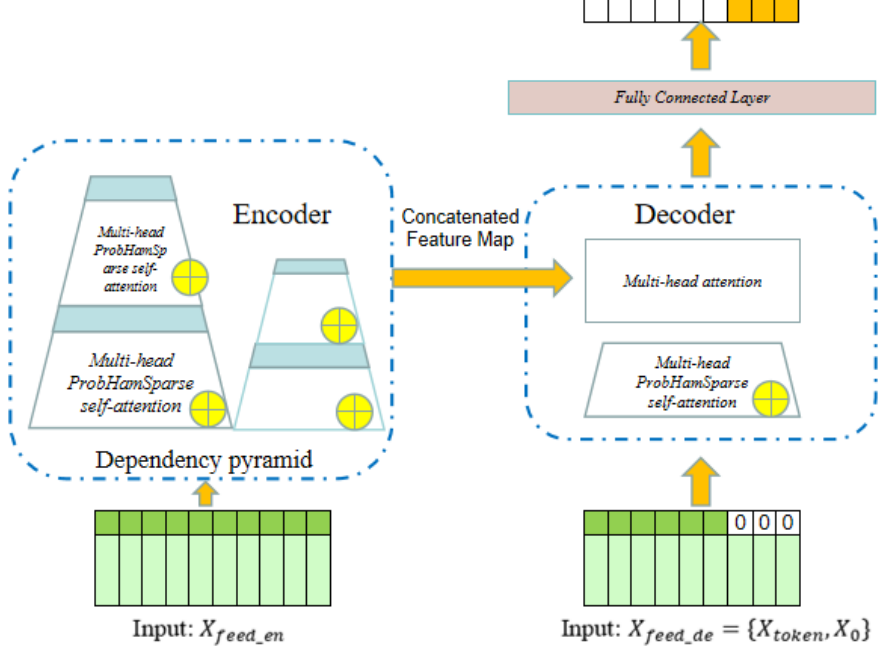
Figure 3. Improved Informer